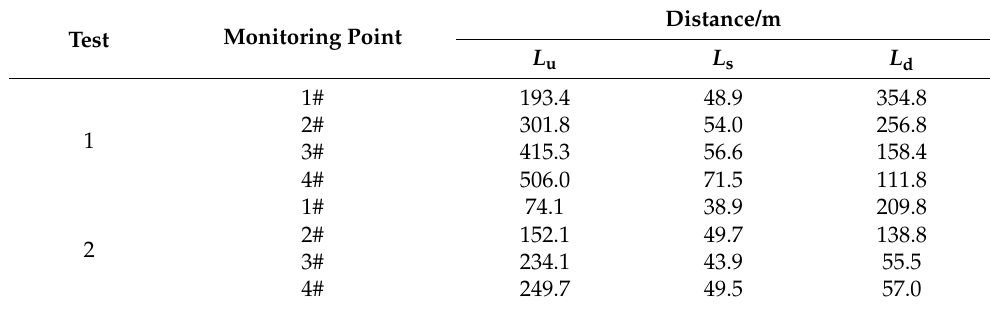
Table 1. Monitoring point and distance data.